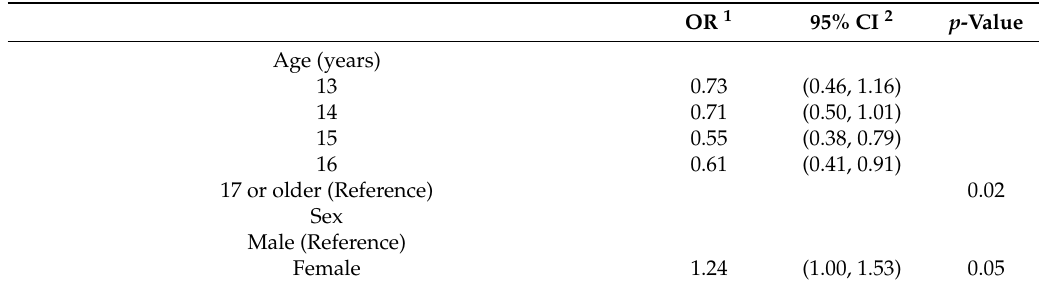
Table 2. Final multivariate model of correlates of travelling to school by